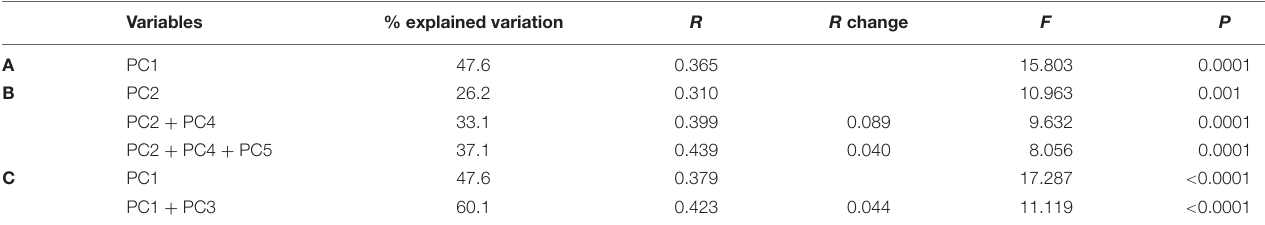
Variables % explained